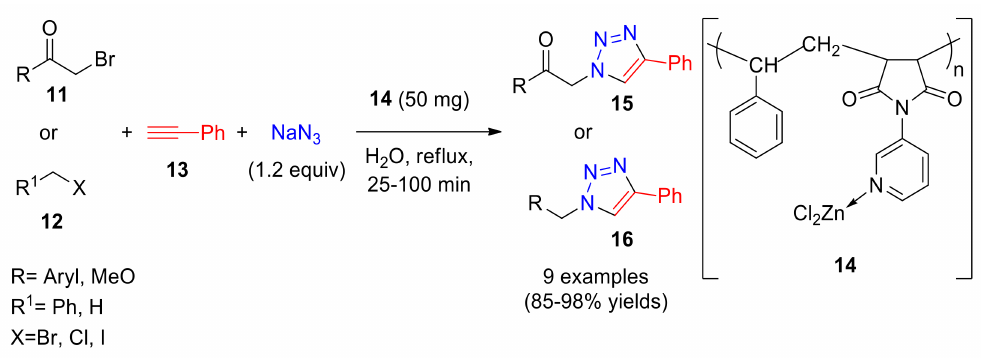
Scheme 6. Synthesis of 1,4-DTs in the presence of